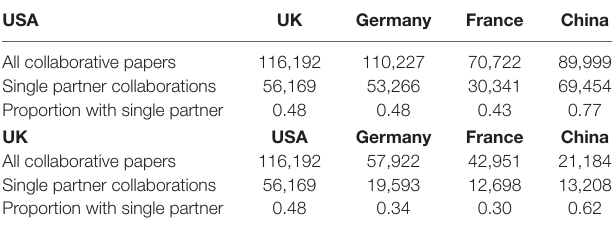
TaBle 2 | The number of papers co-authored by the US and the UK with four major international partners during 2002–2011. Usa UK germany France china